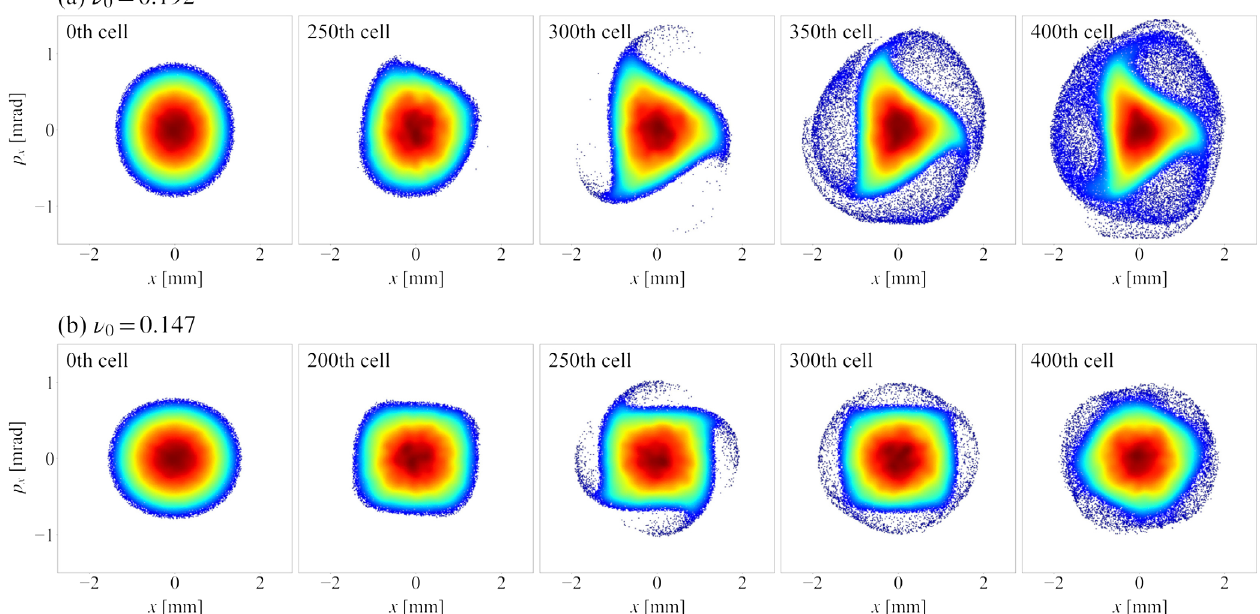
FIG. 2. Results of 2D W ARP simulations. We have assumed a proton beam propagating through the symmetric sinusoidal focusing channel at the kinetic energy of 1 MeV. The external force is perfectly linear (no error fields). The initial distribution is the waterbag-type matched to the lattice. The tune depressions are adjusted to η x ¼ η y ¼ 0 . 8 at the beginning. The ordinate represents the horizontal kinetic momentum normalized with the design value. The transverse bare tunes have been set equal ð ν 0 x ¼ ν 0 y Þ and chosen to be (a) ν 0 ¼ 0 . 192 and (b) ν 0 ¼ 0 . 147 . According to the coherent resonance condition in Eq. (7), the operating point is located within the sextupole ( m ¼ 3 ) stop band in the former case and within the octupole ( m ¼ 4 ) stop band in the